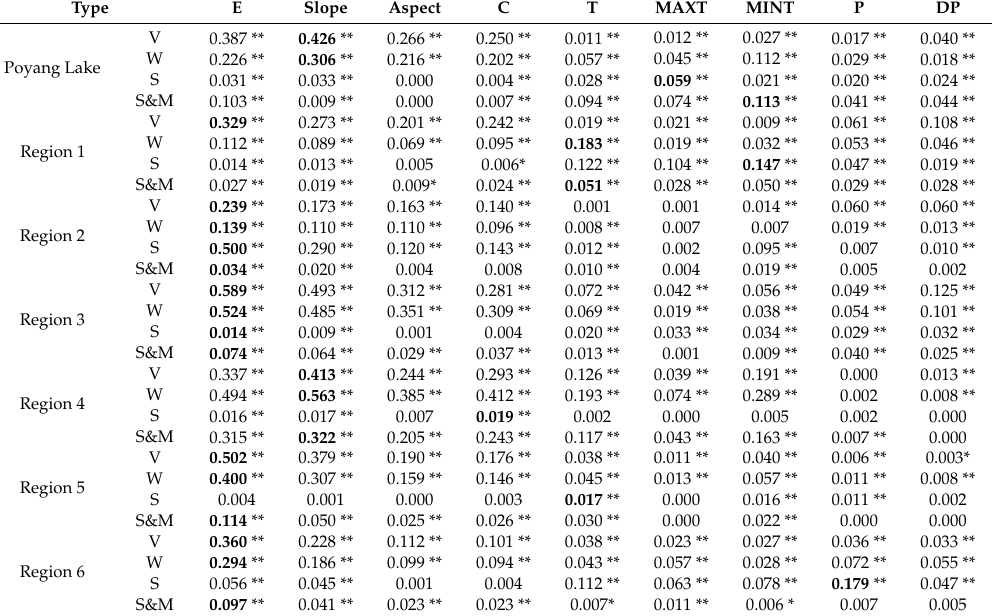
Table 6. q values of driving factors a ff ecting the distribution of wetland landcover types between 1973 and